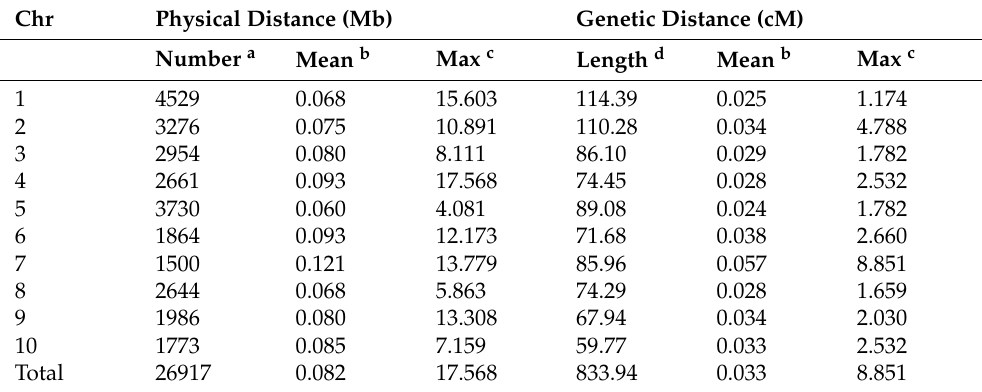
Table 1. Profile of the linkage map.